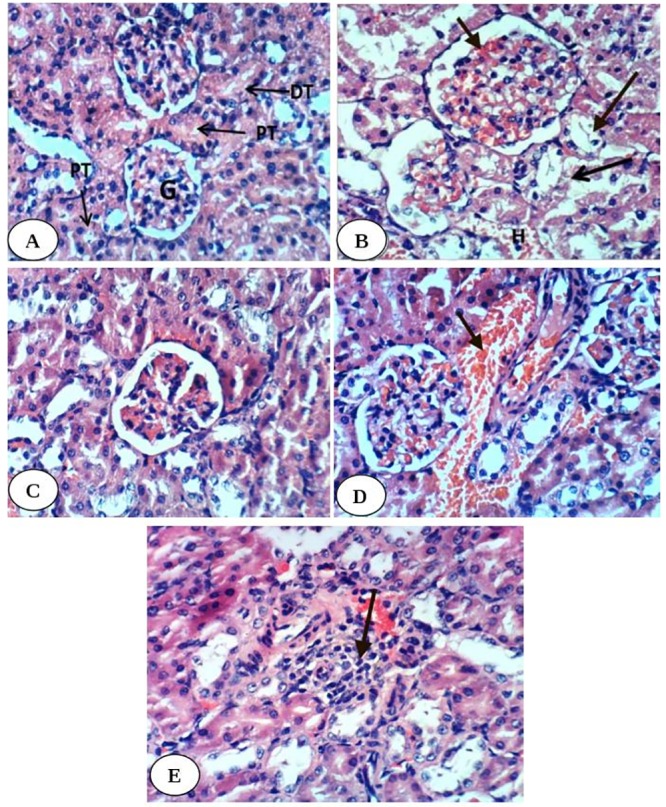
Photomicrographs of H & E stained kidney sections.Fig 1A is showing normal kidney histological structure with normal glomerulus (G), normal proximal tubule (PT) and normal distal tubule (DT). Fig 1B is showing severe diffuse tubular necrosis (long arrow), severe congestion of glomerular tuft (short arrow) and intertubular hemorrhage (H) in diabetic group. Fig 1C is showing normal histological structure in diabetic group treated with enalapril. Fig 1D is showing congestion of blood vessel (arrow) in diabetic group treated with paricalcitol. Fig 1E is showing focal necrosis and inflammatory cell infiltration (arrow) in diabetic rats treated with both enalapril and paricalcitol. (H&E; 400X).